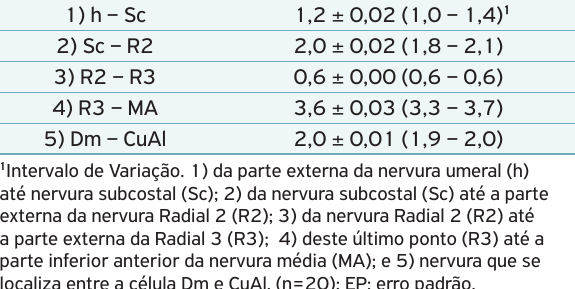
Tabela 4. Média ( ± erro padrão) das medidas das nervuras das asas de machos de Neosilba perezi em milímetros.